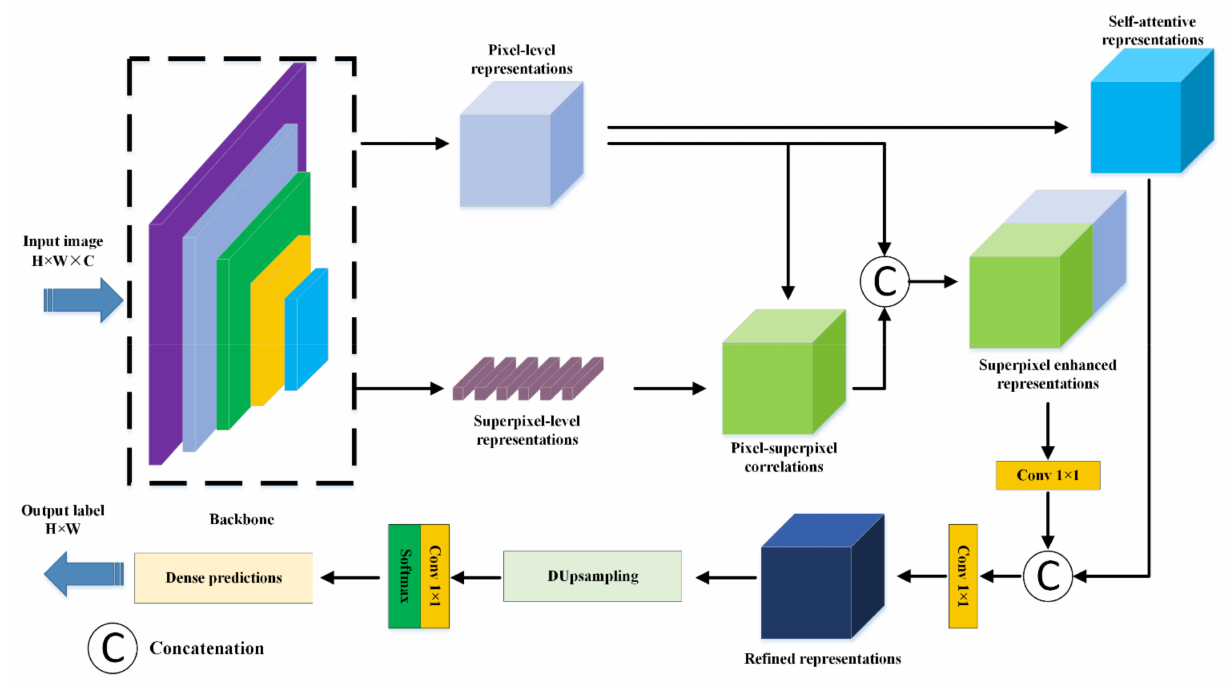
Figure 4. Overall framework of